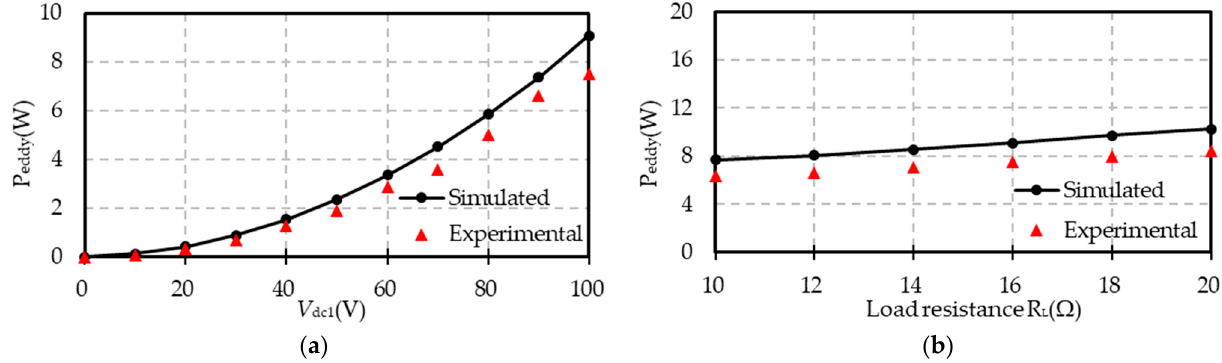
Figure 10. Eddy current loss variation in seawater condition. ( a ) With V dc1 ; ( b ) With load resistance R L .